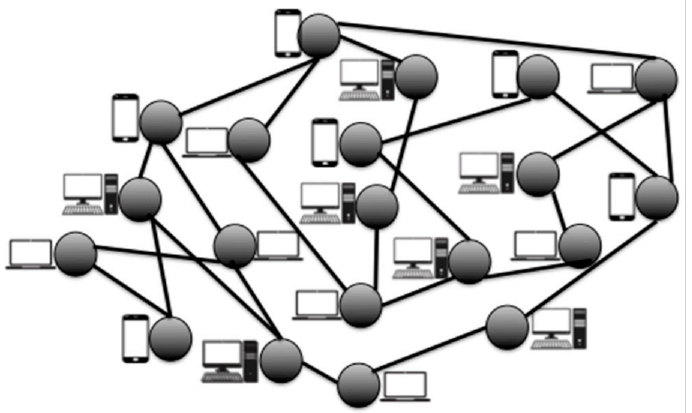
Figure 2. Public